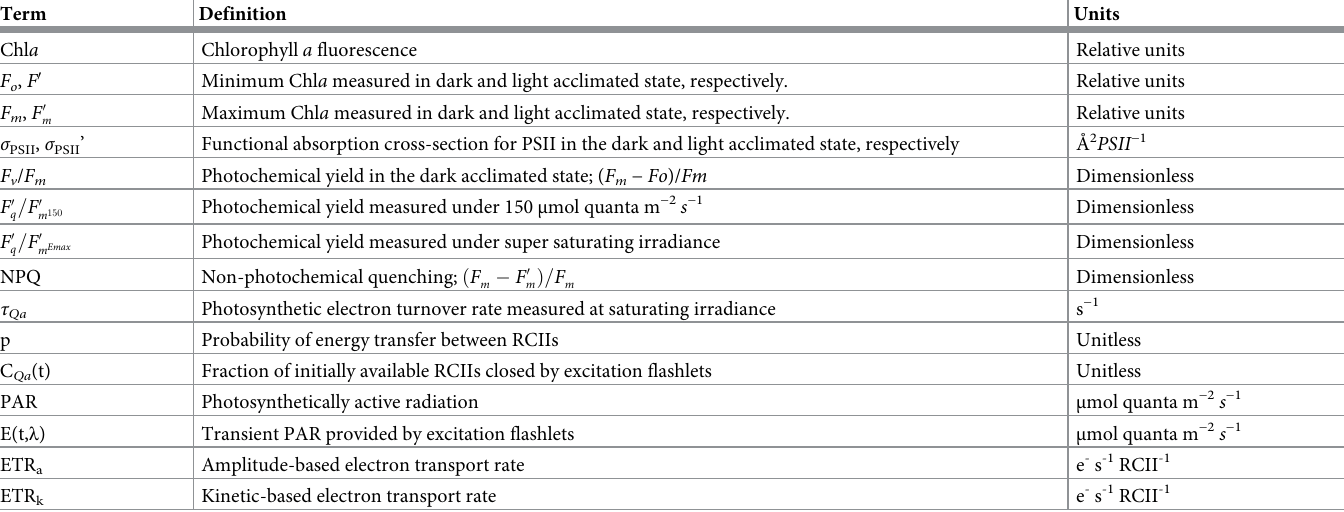
Table 1. Commonly referred to photophysiological terms and